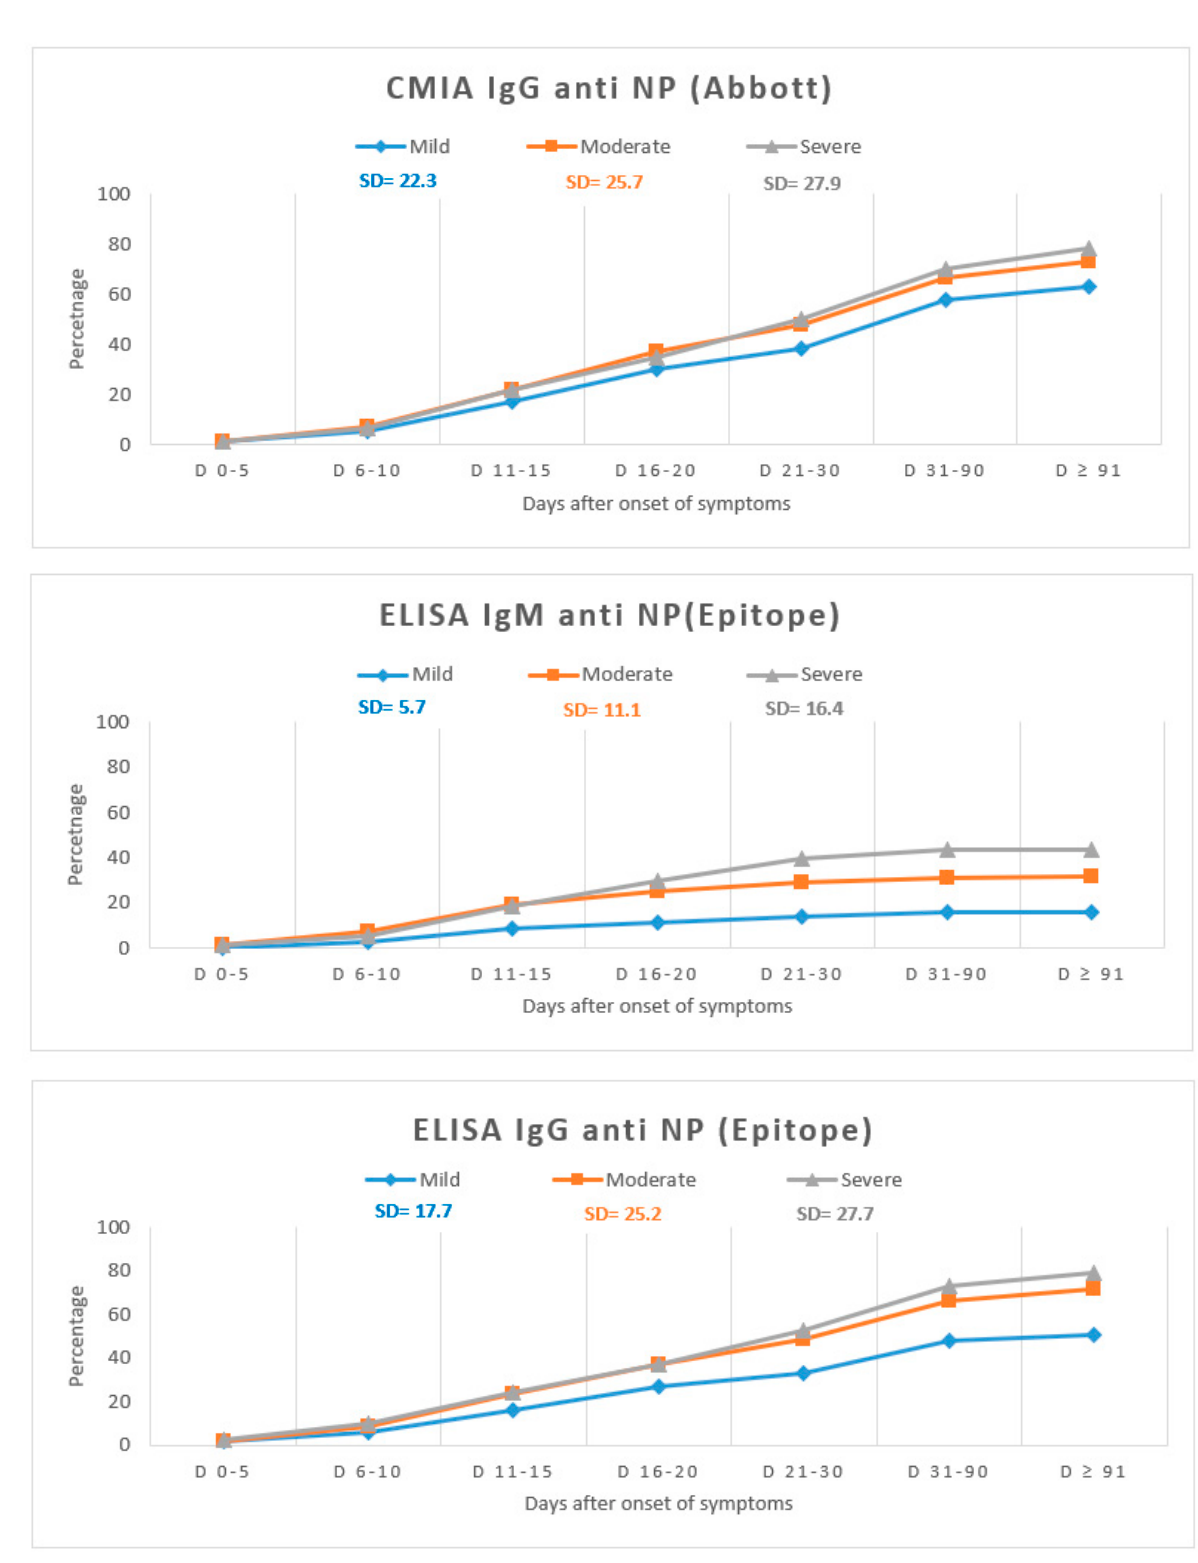
Figure 2. Variation in antibodies positivity by disease severity. SD = standard deviation. Each time point from the x-axis represents the cumulated seropositivity rate at that specific time point.